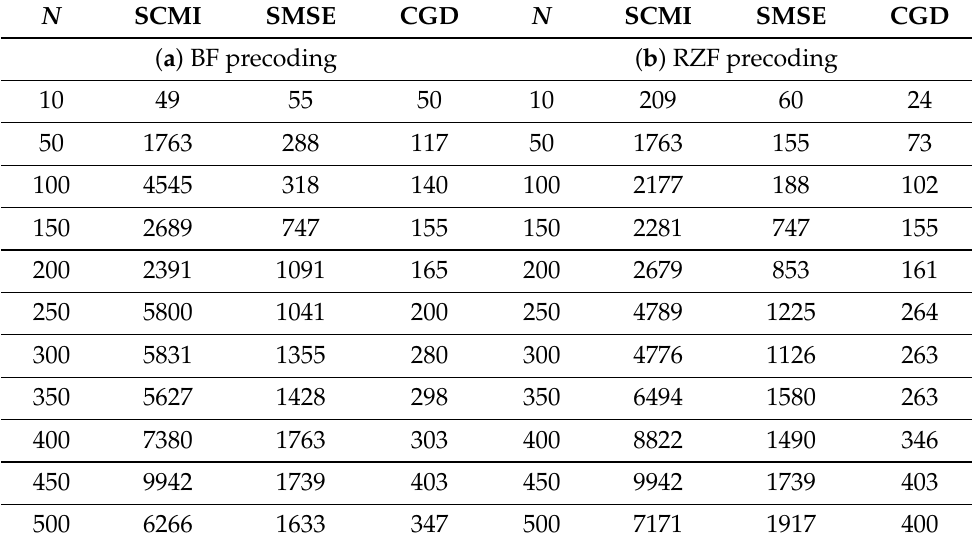
Table 6. The number of iterations per each training sequence algorithm required to converge with respect to the number of BS antennas N for the pilot length in BF and RZF precoding in the OR model with ω = 5 ◦ , D = 1/2, T = 100 symbols, ρ d = 10 dB and K = 6 users.